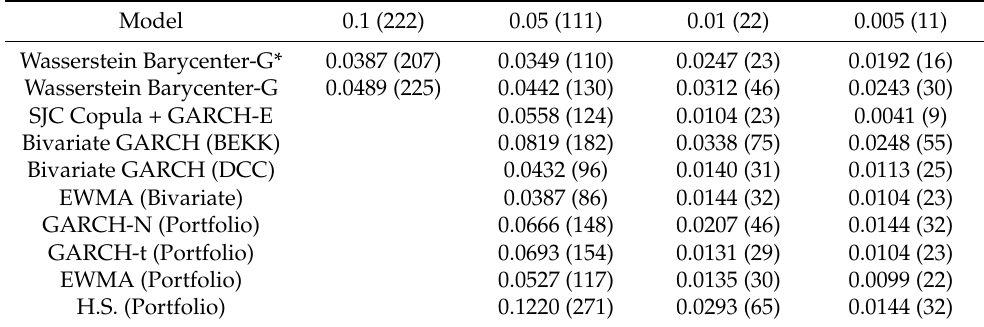
Table 4. VaR for t = 751 to 2971, number of exceptions (in brackets), where the estimated VaR was exceeded by the portfolio loss, with α = 0.1,0.05,0.01,0.005.